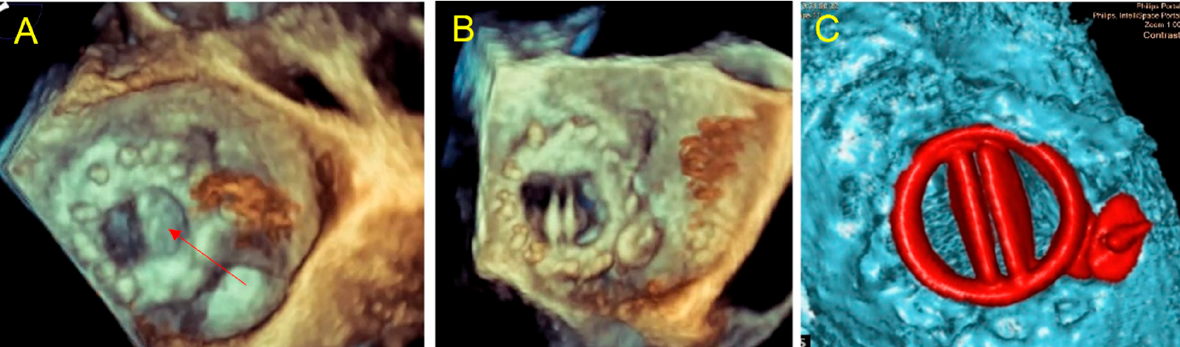
Figure 4. Case 1: per procedural imaging. ( A ) Per procedural 3D TEE in atrial view: Amplatzer Valvular Plug III 3–12 mm blocks the internal prosthetic disc (red arrow); ( B ) traction of the device to adjust its positioning allowing to free the prosthetic disc movements. The position is similar to the simulation on 3D printed model; ( C ) late control CT, good device positioning without leaflet impairment, no residual mitral paravalvular gap, the plug is located as on 3D printed model simulation.